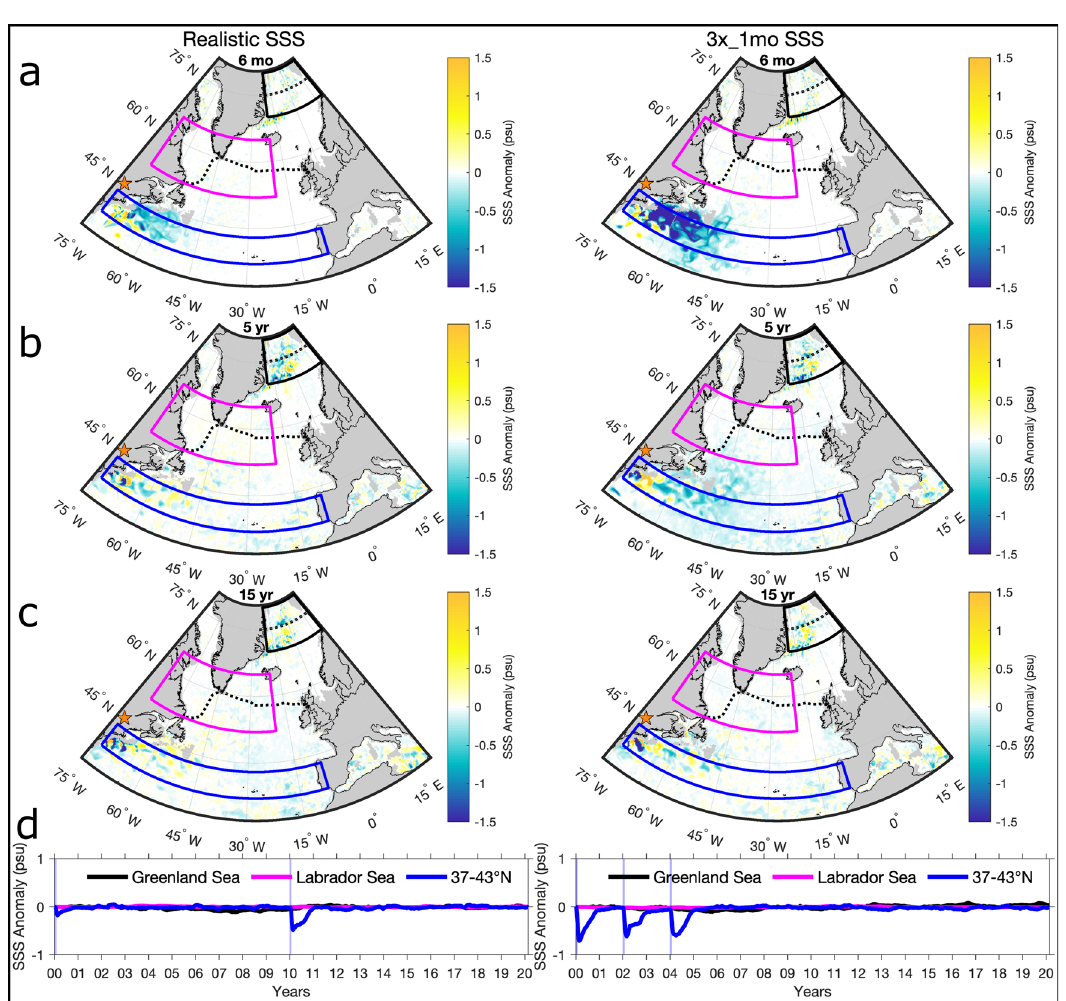
Fig. 2 SSS impacts of Hudson Valley Glacial fl oods. SSS anomalies (relative to a control simulation) across the N. Atlantic at 6 months ( a ), 5 years ( b ), and 15 years ( c ) of model run time. The left panels show the “ Realistic ” simulation with a 0.31 Sv fl ood followed by a 1.09 Sv fl ood 10 years later. The right panels show the most extreme scenario (3x_1mo) with the maximum combined fl ood (1.40 Sv) repeated three times, 2 years apart. All fl ood durations are 1 month, and the experimental and control simulations are both run with a constant 0.05 Sv meltwater fl ux from the Hudson Valley. Approximate location of glacial Lake Iroquois shown by a star. d shows the mean SSS anomaly throughout the simulation for the corresponding boxes shown on the maps with fl ood events shown with vertical blue